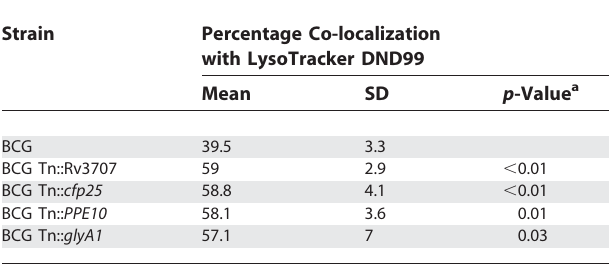
Table 3. Confocal Microscopy Analysis of FACS-Selected Mutants Confirms Increased Localisation in Acidic Phagosomes